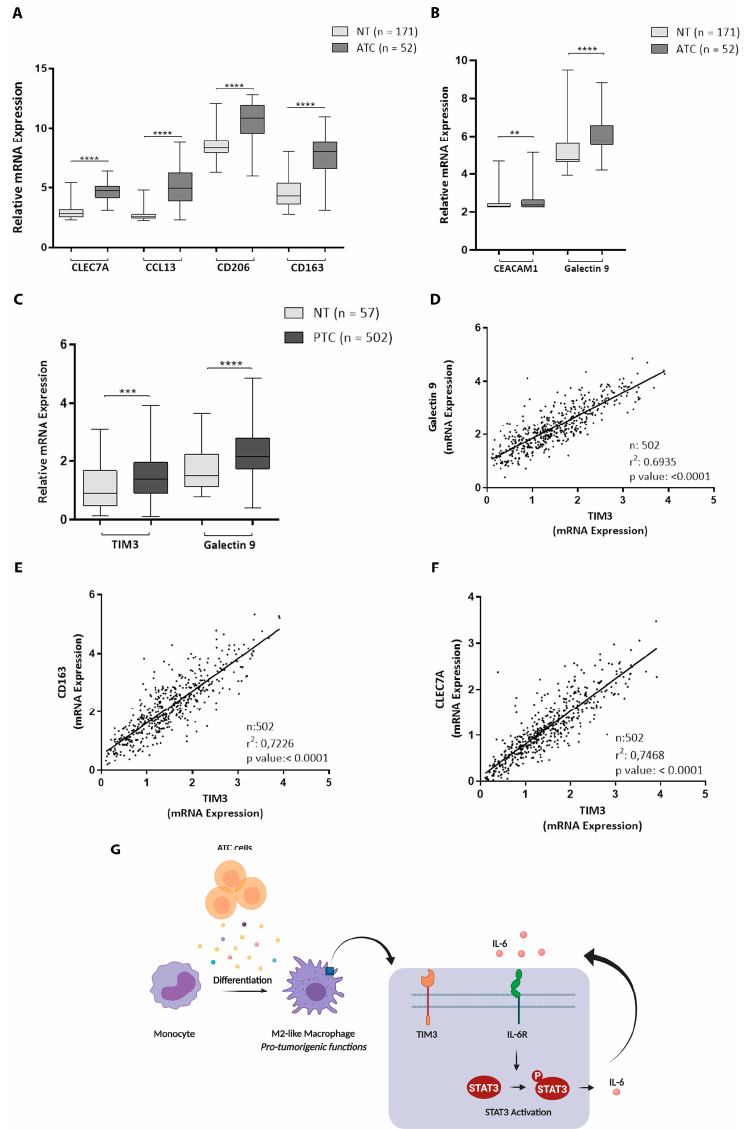
Figure 6. M2 markers, ligands of TIM3 and TIM3 expression in human thyroid tissues. ( A ) Boxplots showing CLEC7A, CCL13, CD206, and CD163 gene expression in normal thyroids (NT) and